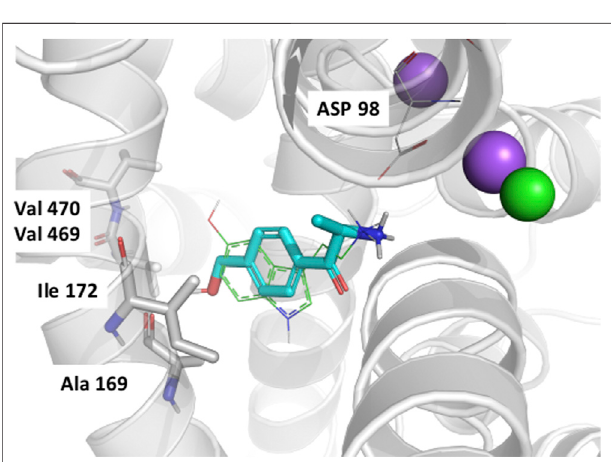
FIGURE 5 | QSARs. Docking pose of R-4-OH-MC in the outward occluded model of SERT bound to 5HT (Hellsberg et al., 2018). The hSERT is represented in transparent gray cartoons, with the residues constituting subsiteBshowninsticks,andlabeled.Thesodiumandchlorideionsare represented in purple and green spheres, respectively. The 5HT molecule bound totheSERT modelisrepresentedingreenlines,whilethedockedR-4- OH-MC is shown in cyan sticks. The fi gure has been created with Pymol (Schrodinger, L. L. C. The PyMOL Molecular Graphics System, Version 2.2.).